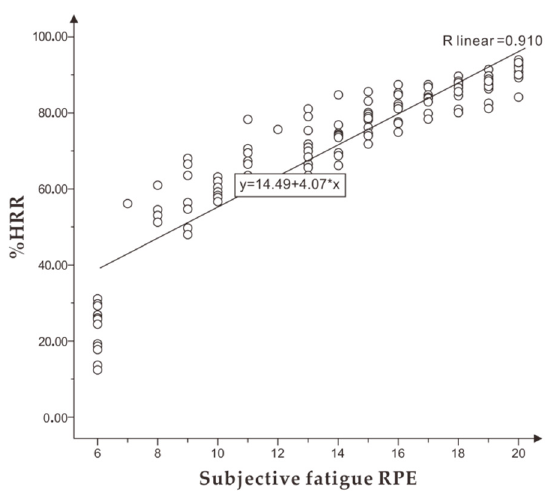
Figure 7. The correlation between %HRR and subjective fatigue RPE in the constant load experiment.